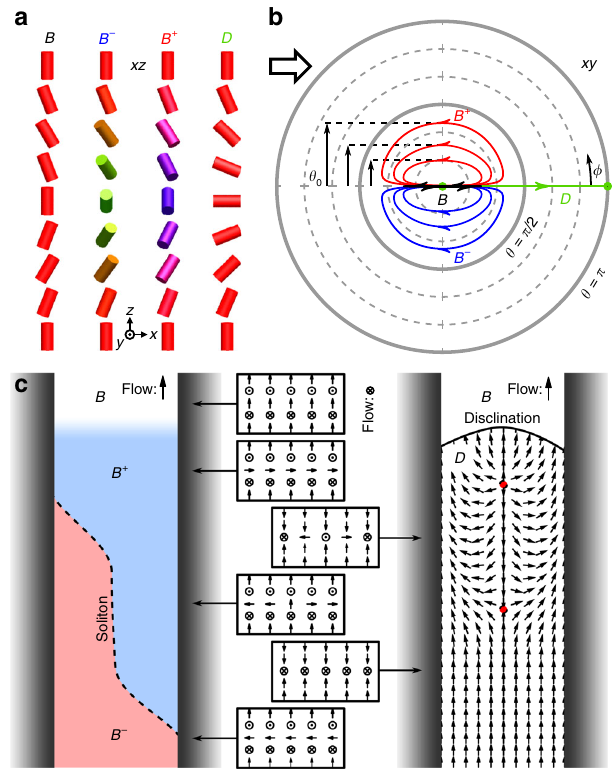
Fig. 4 Idealised schematics of fl ow-induced director pro fi les. a Typical columns of vertical cross section of each state, showing the characteristic director pro fi le. B ± states are mirror images of each other. b Polar plot, representing the directions traced by the four states of fl ow when z coordinate traverses the height of the channel. B state only deviates back and forth in the direction of fl ow, chiral B ± states deviate sideways, tracing a clockwise or anticlockwise path when viewed from the top, and the D state completes a full π turn. The mid-cell deviation θ 0 measures the degree of symmetry breaking in the chiral B (cid:3) phase (denoted by black vertical arrows). The sketch depicts a few examples of how the pro fi le behaves at different amplitudes and handedness. See Fig. 5 for quantitative simulation results. c Schematic depiction of transitions and solitons between the observed states. Left: the achiral B state transitions into the chiral B ± states via a second-order phase transition. Transitions between B ± states are carried by nonsingular solitons (dashed line). Right: transitions from all B -type states into the D state are fi rst-order and are separated by a disclination line. The dowser state is a polar quasi-planar state, which contains its own dynamics of point defects (red